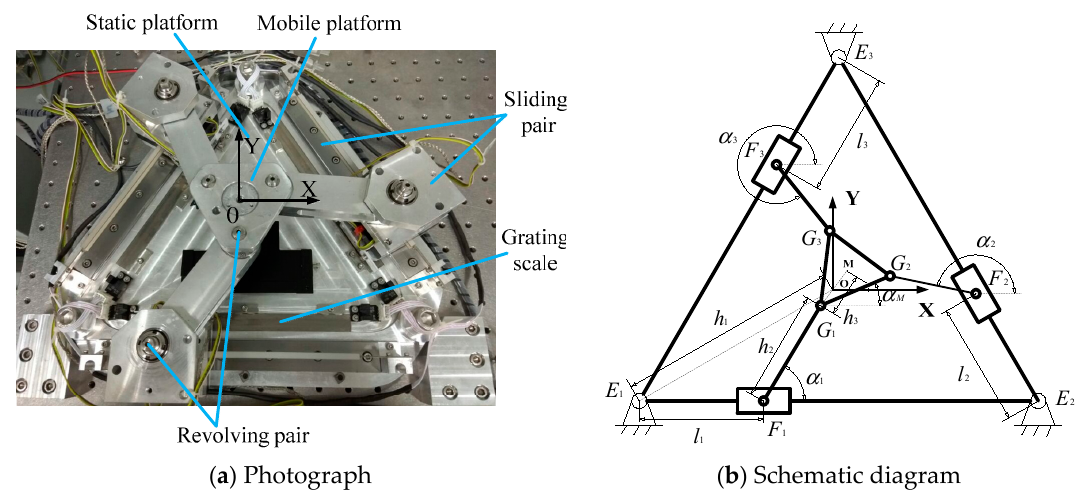
Figure 2. Photograph and schematic diagram of the 3-PRR (three links with each link consisting of a prismatic pair and two rotating pairs) parallel platform.